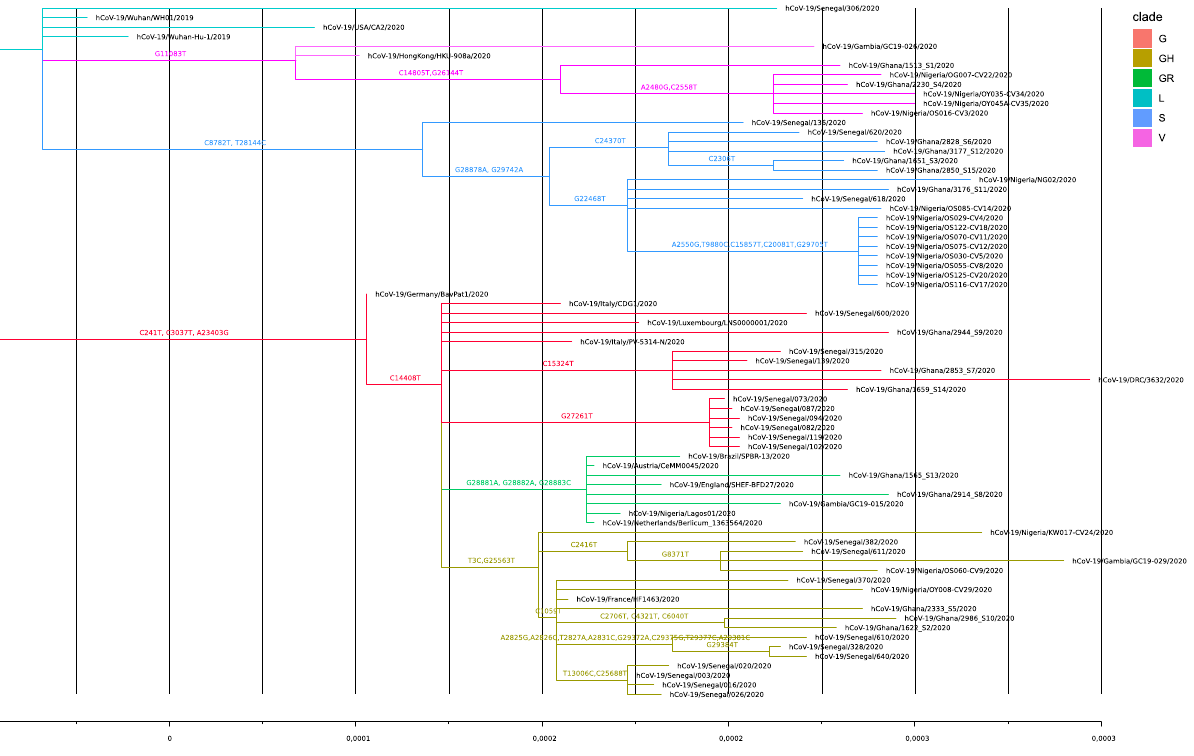
specific, e.g. most Senegalese samples have close similarity with the French reference, most Nigerian samples cluster in early Chinese-based clade S and Ghanaian samples are spread over all clades. Within the clade S, there are putatively specific West-African mutations at the branches at C24370T and G22468T. G22486T may reflect migration routes because in the nextstrain analysis of Africa as a whole there are also Tunisian samples in this branch (https:// nexts train. org/ ncov/ africa? f_ region= Africa, accessed Jun 26th, 2020). Two of the non-French related Senegalese samples come from these branches while the other (Senegal/136) has strong similarity with Spanish-end of February samples from the early clade S pointing at multiple introductions to Senegal from France, Spain and African countries. Graphics were generated using the software FigTree (version 1.4.4,